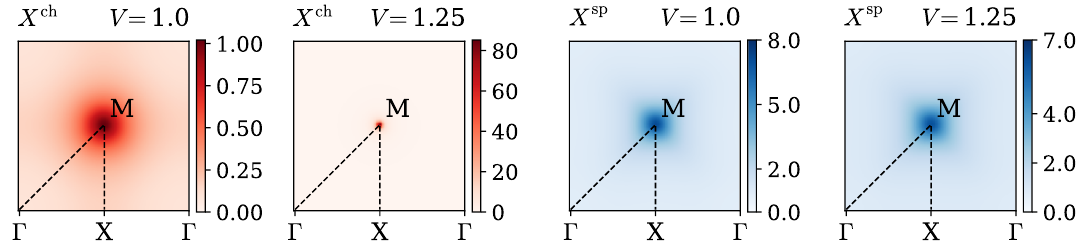
Figure 7: Static charge (red panels) and spin (blue panels) susceptibilities X ch / sp ( q , ω = 0 ) in the Brillouin zone. Calculations are performed for the half-filled single-band extended Hubbard model on a square lattice for U = 4 and β = 4. The value of the non-local interaction V is indicated above each